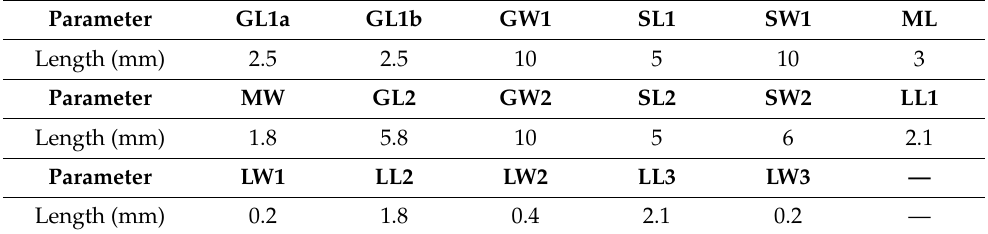
Table 1. The geometric parameters of the MDCRP structure